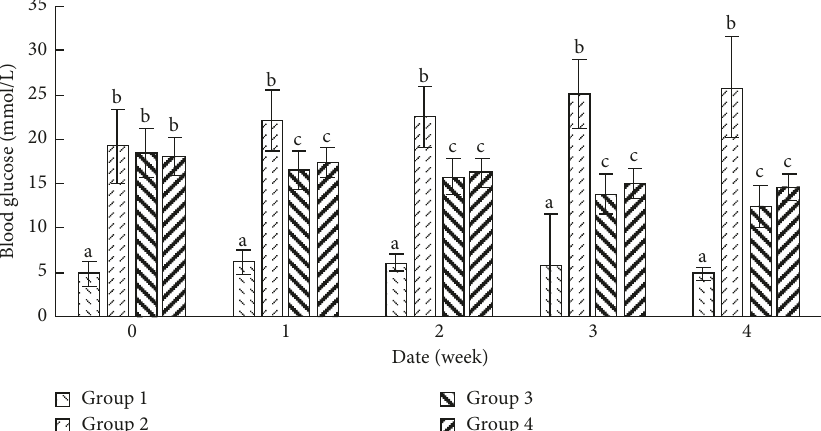
Figure 2: Effects of SDF on blood glucose level in nondiabetic and diabetic mouses. Data are expressed as mean ± standard deviation (SD). Values with different letters on the same histogram are significantly different, p ≤ 0 . 05. Group 1: nondiabetic group; Group 2: diabetes model group; Group 3: metformin group; Group 4: SDF